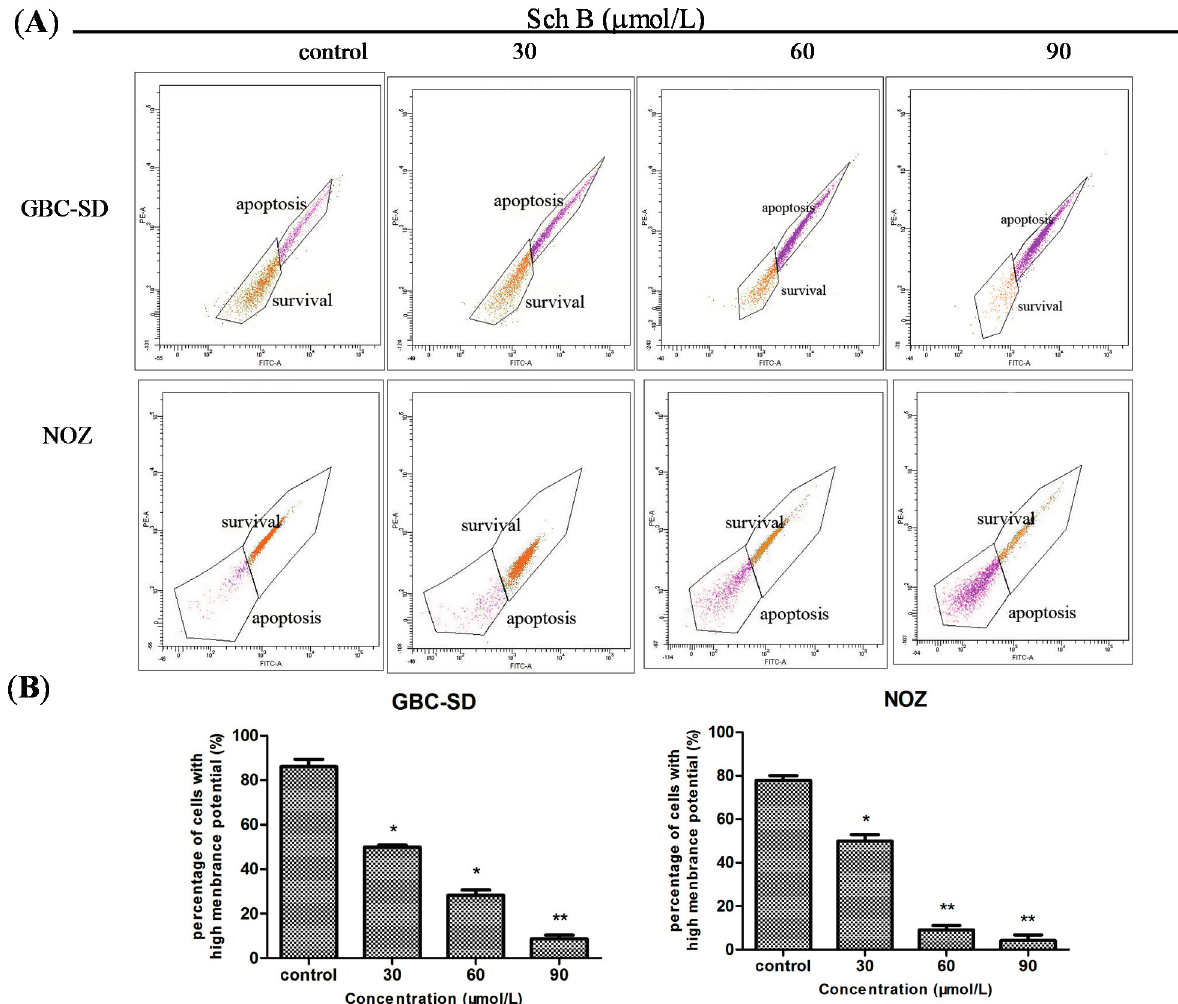
Figure 4. Sch B decreases mitochondrial membrane potential ( ΔΨ m) in gallbladder cancer cells. ( A ) GBC-SD and NOZ cells were treated with Sch B (0, 30, 60, and 90 μ mol/L) for 48 h. Rhodamine retention was measured by flow cytometry. ( B ) The corresponding histogram shows the percentages of survival cells (mean ± SD, n = 3); The results shown were representative data from 3 independent experiments. * P < 0.05, ** P < 0.01 vs . the control